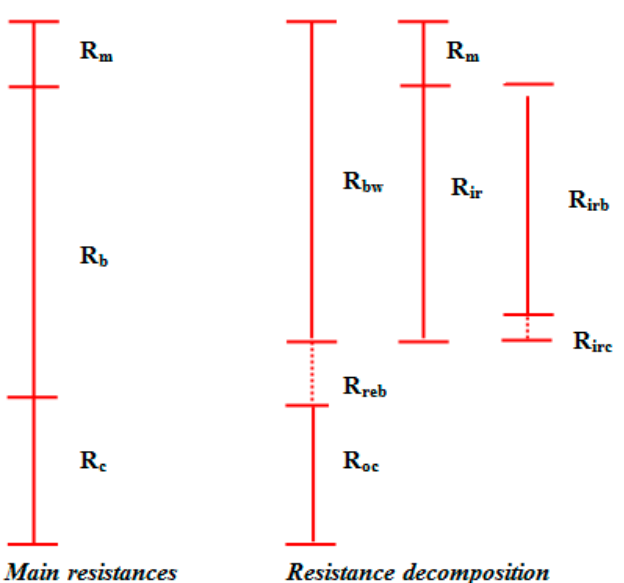
Figure 2. Example of different resistance decomposition (adapted from Jiang et al. [89]).